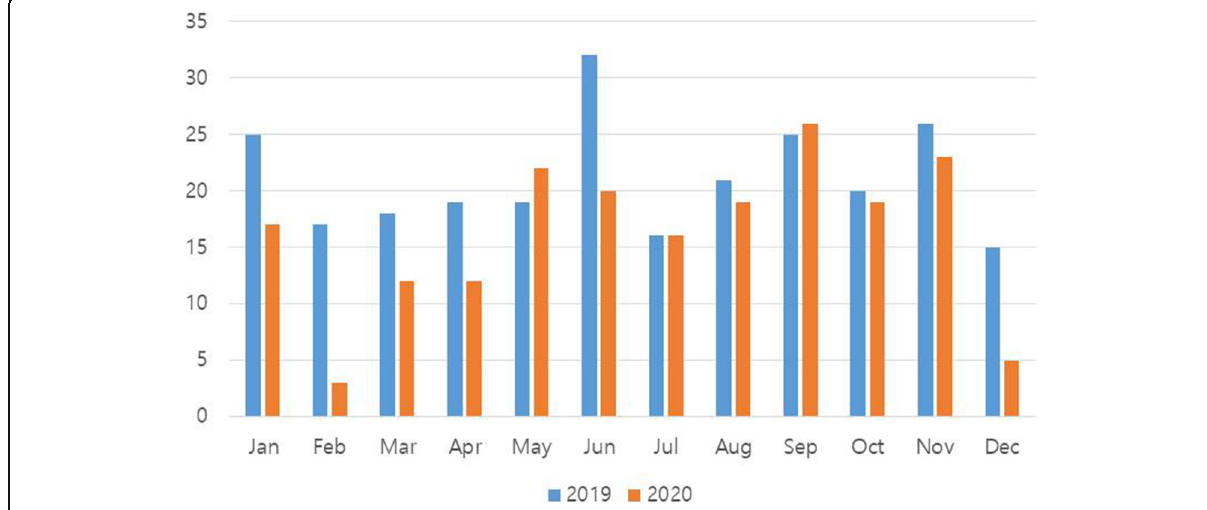
Fig. 2 Monthly number of oral and maxillofacial fracture patients during 2019 and 2020